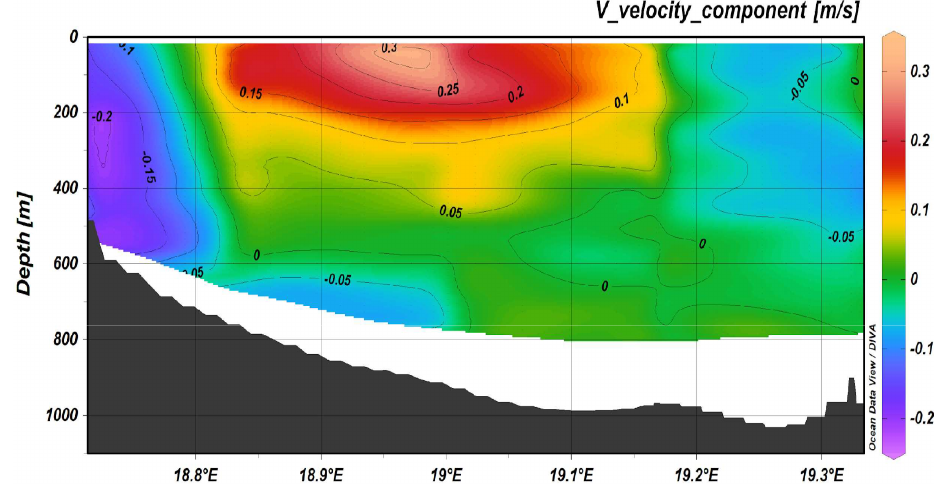
Figure 4. Transect across the Otranto Strait from ADCP 38, positive numbers correspond to northward currents.